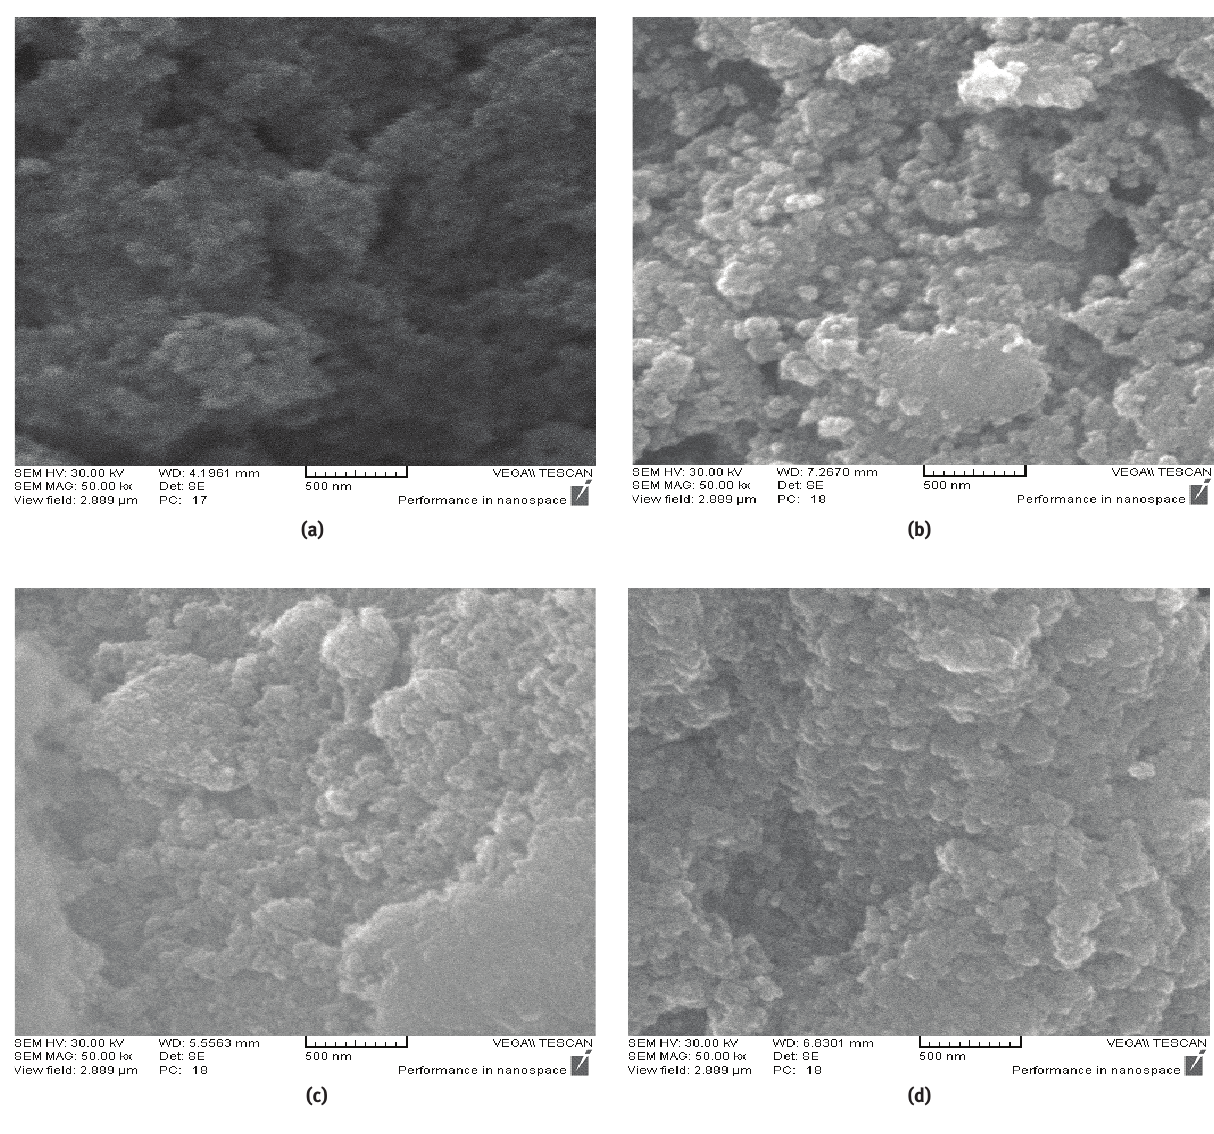
(WO ) nanoparticles synthesized via the chemical precipitation reaction at different runs of Table 1: (a) run 1, (b) 2 4 3